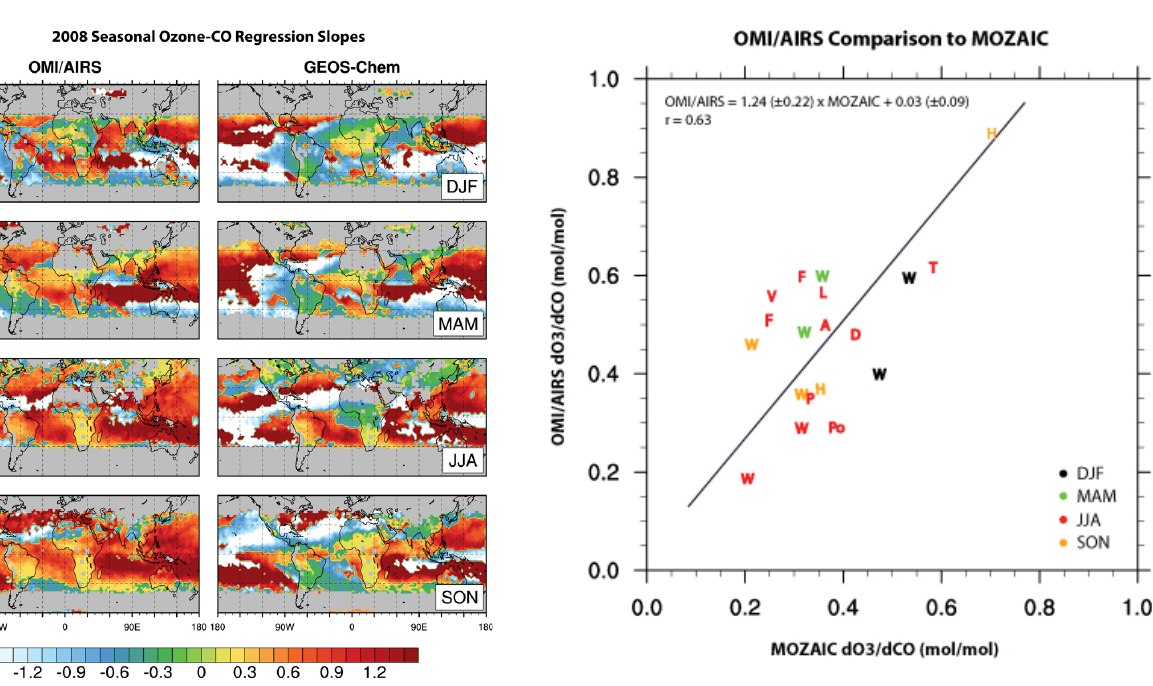
Fig. 2b. Same as Fig. 2a but for the ozone–CO RMA regression slope ( d O 3 / d CO).